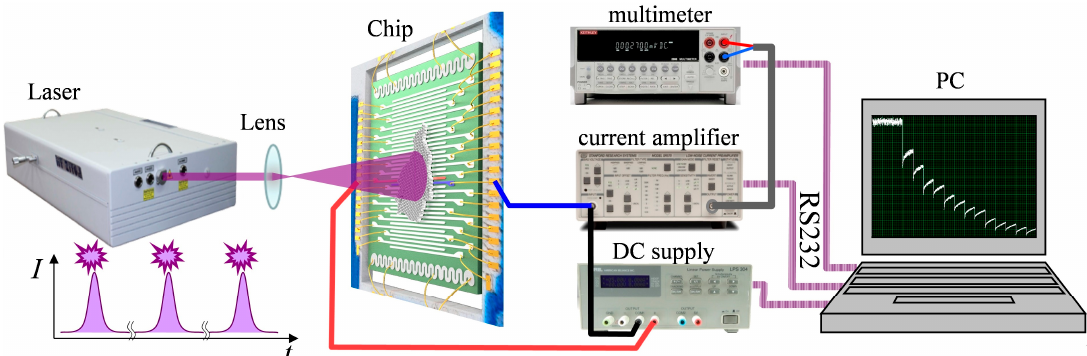
Figure 2. The scheme of experimental setup to measure the dc conductance of the aTNTA layer under laser irradiation in the range from 355 to 575 nm.